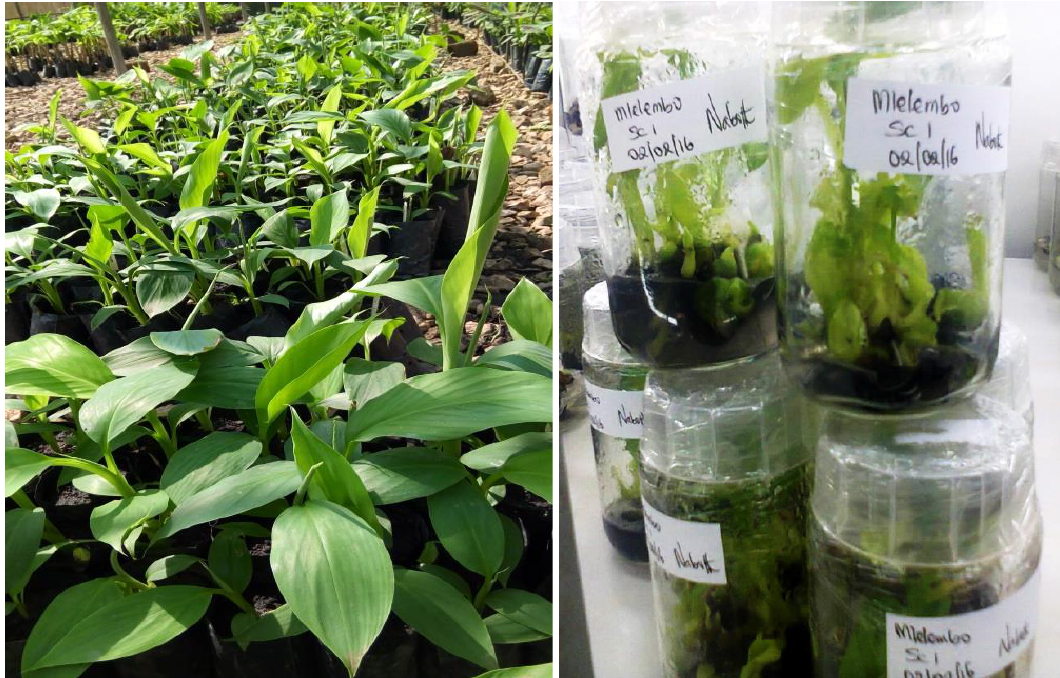
Figure 5: Banana plantlets generated through tissue